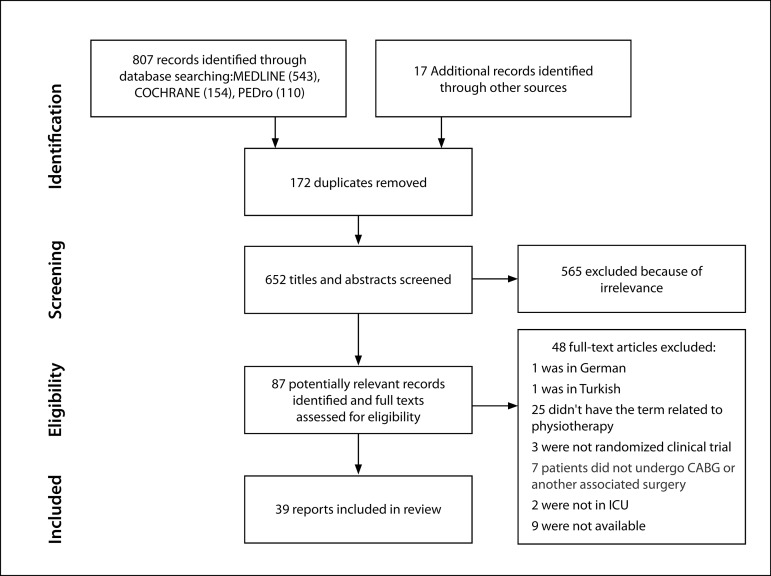
Study flowchart.